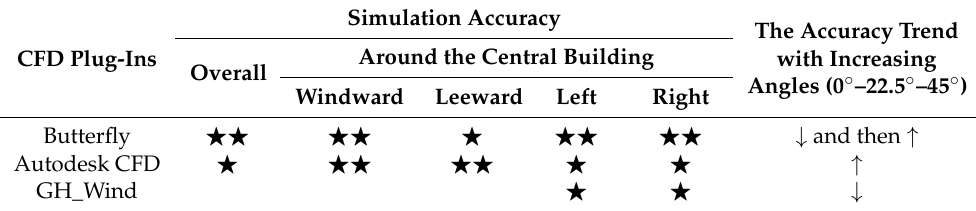
Table 5. Comparison of simulation accuracy of different CFD